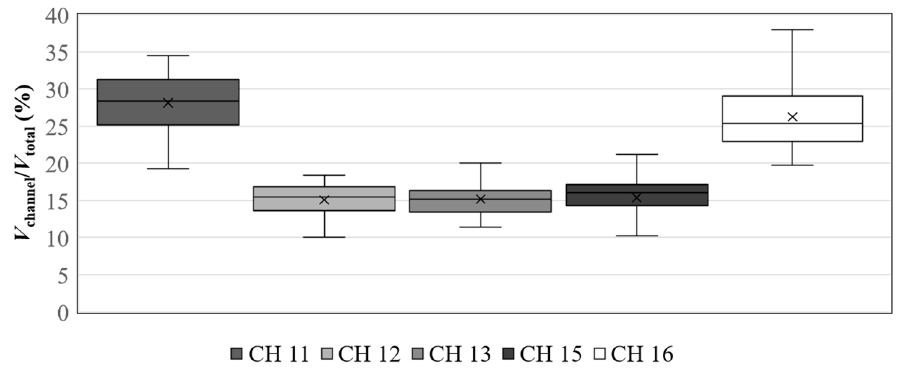
Figure 5. Overtopping volume distribution over the five dam crest sections (see Figure 2b for the position of sensors).